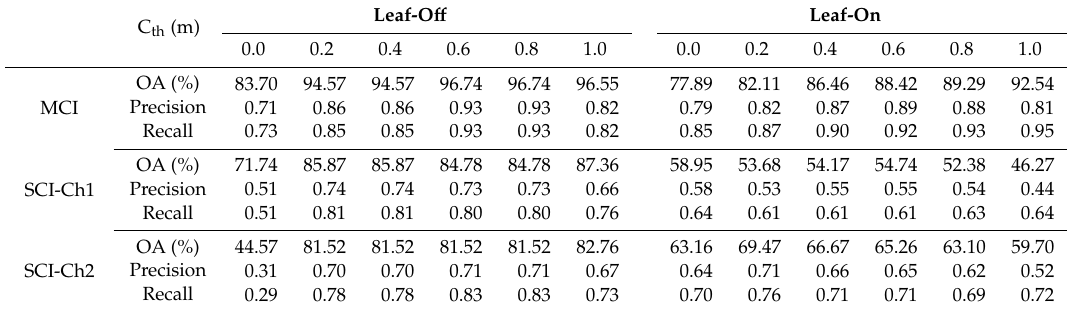
Table 6. Accuracy of classification when canopy threshold (C th ) varied from 0 to 1 m in leaf-o ff and leaf-on conditions using multichannel intensity (MCI) features and only single-channel intensity (SCI-Ch1 and only SCI-Ch2). OA: overall accuracy; recall and precision: mean precision and recall values of all three (Norway spruce, birch, and nontree) classes, respectively.